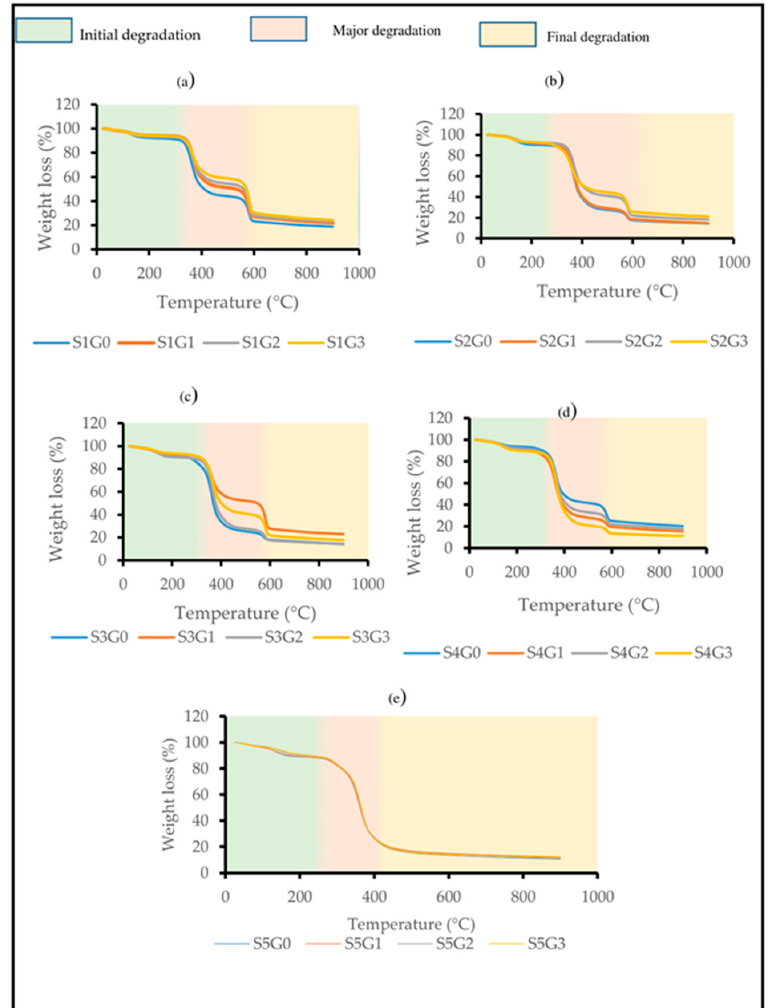
Figure 4. E ff ect of GNP on the thermal stability of laminated composites. ( a ) S1, ( b ) S2, ( c ) S3, ( d ) S4, ( e )